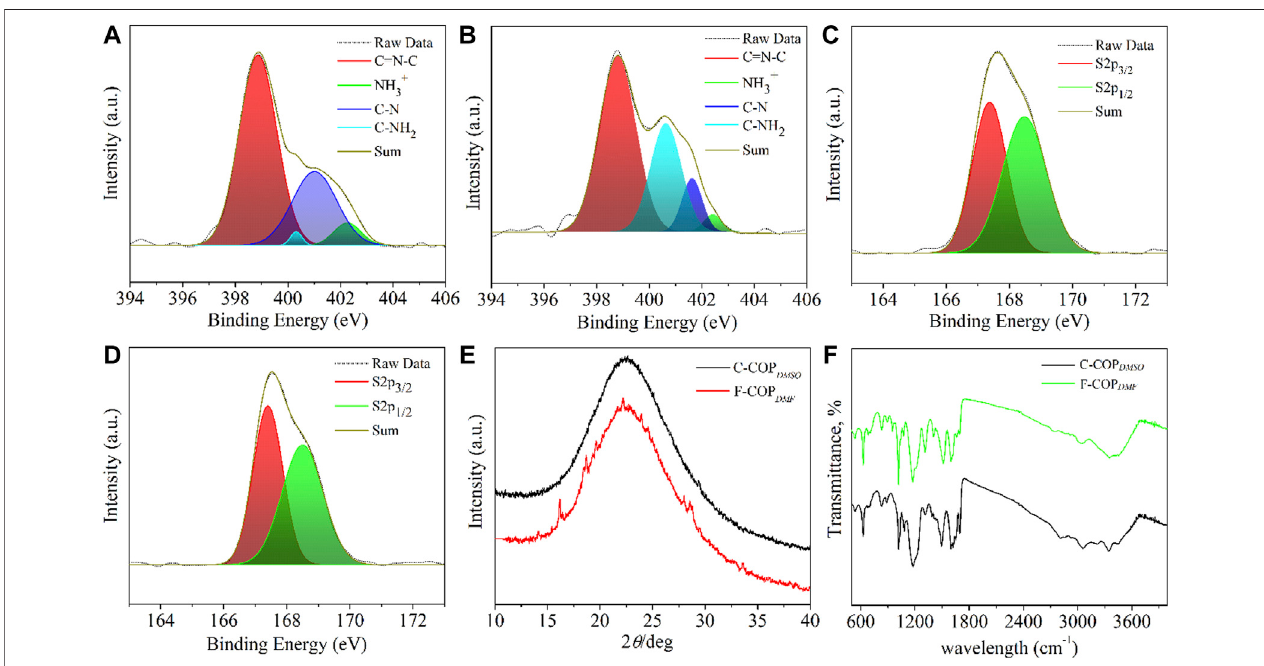
FIGURE 3 | (A) N1s of F-COP DMF ; (B) N1s of C-COP DMSO ; (C) S2p of F-COP DMF ; (D) S2p of C-COP DMSO ; (E) XRD spectra; and (F) FT-IR